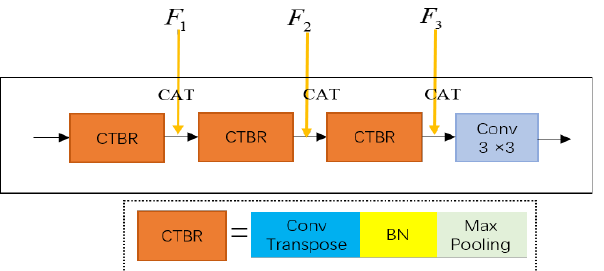
Figure 5. Feature reconstruction module. The features are upsampled through deconvolution blocks, and fused with F 1 , F 2 , and F 3 features extracted from features extraction through skip connections to obtain enhanced features.